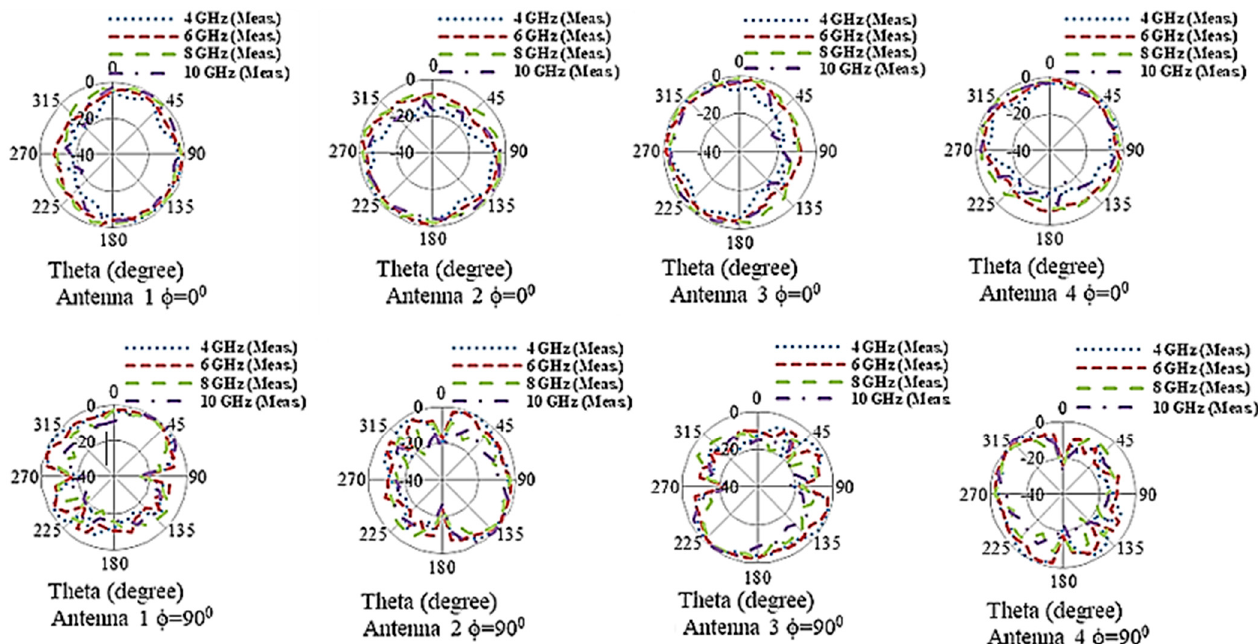
Figure 8. Measured radiation patterns of the UWB MIMO antenna in x - z plane and y- z plane. Table 1. UWB MIMO antenna performance at different